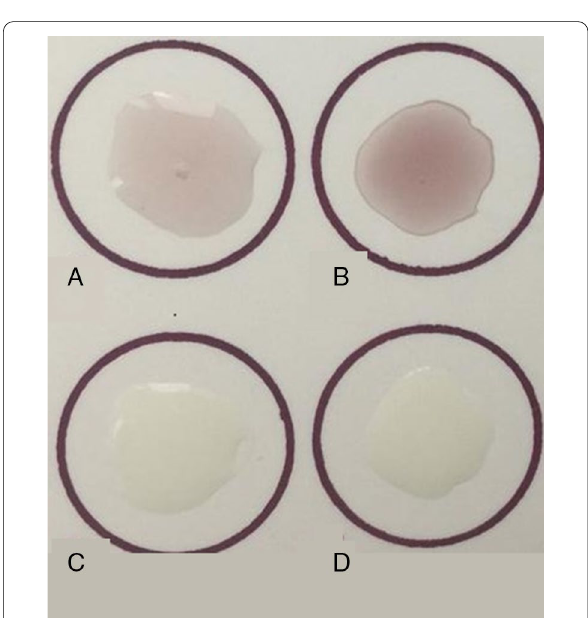
Fig. 5 Redox-cycling nitro blue tetrazolium (NBT) assay for recombinant chimeric Mfp3-GvpA and Mfp3-GvpA adhesive proteins (100 μL of 40 μg/mL). Mfp3-GvpA after modification ( A ). Mfp5-CsgA after modification ( B ). Mfp3-GvpA before modification ( C ). Mfp5-CsgA before modification ( D )